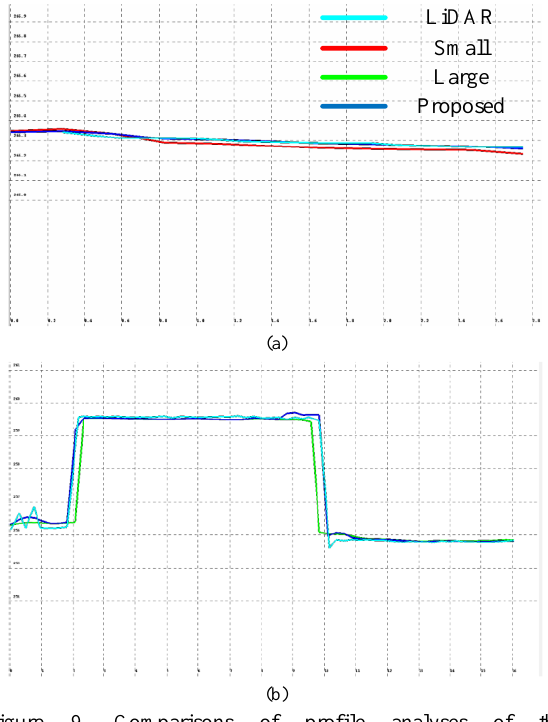
Figure 9. Comparisons of profile analyses of the photogrammetric and airborne LiDAR point clouds in the Vaihingen dataset, on (a) a road area and (b) a building